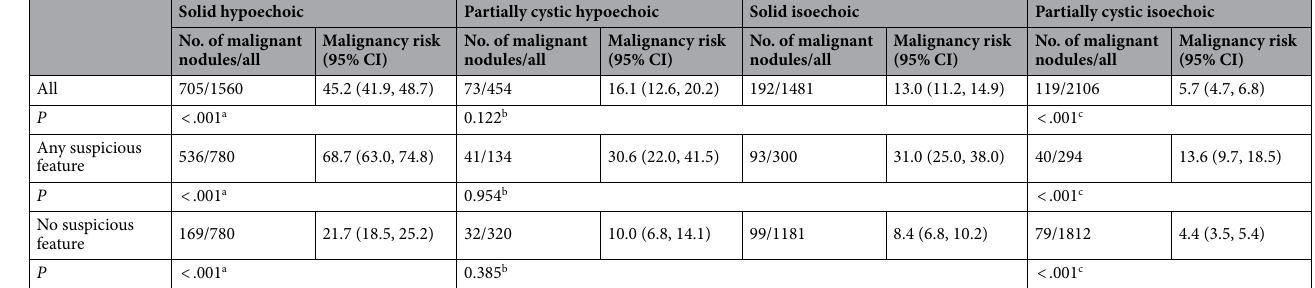
Table 4. Malignancy risk of four nodule categories based on composition and predominant echogenicity. a Solid hypoechoic versus partially cystic hypoechoic. b Partially cystic hypoechoic versus Solid isoechoic. c Solid isoechoic versus partially cystic